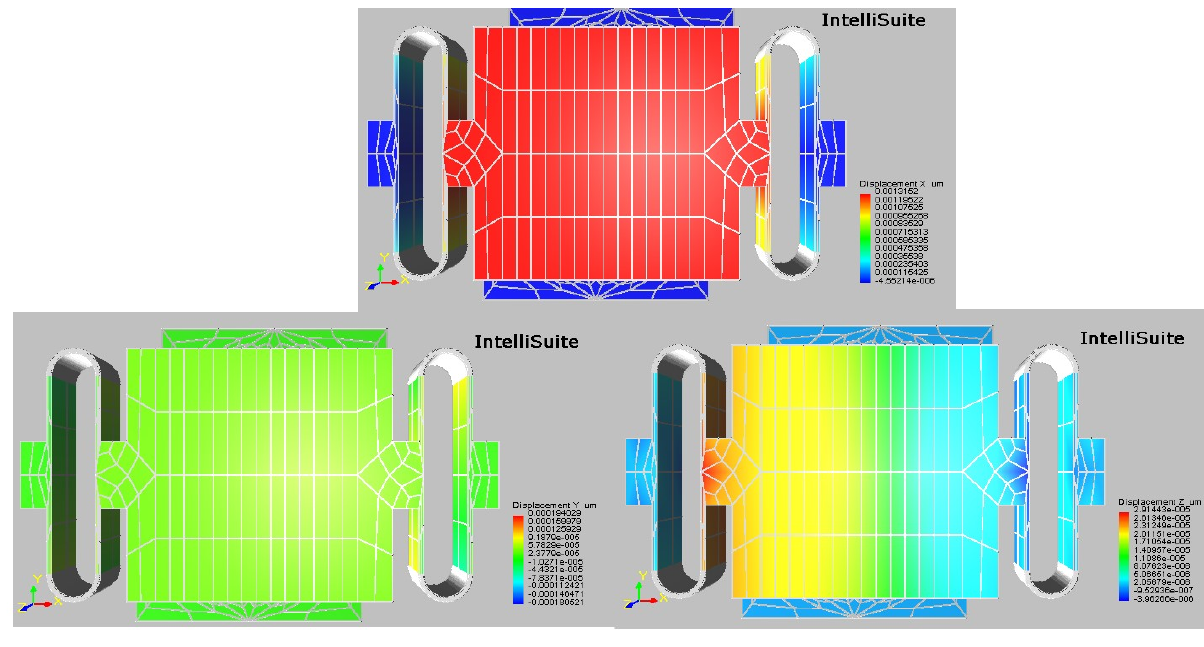
Figure 6: Displacement at axis x, y, z